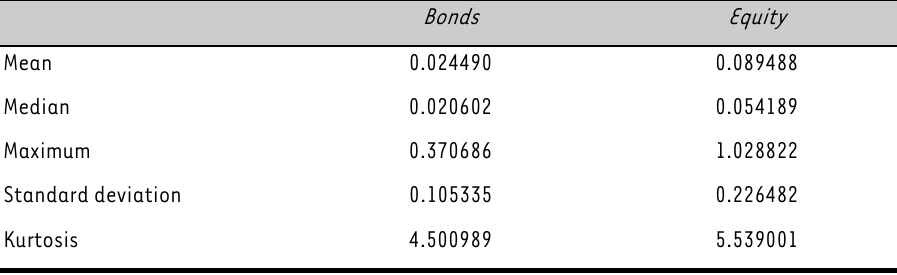
TABLE 3: Descriptive statistics: real equity and bond returns, 1900-2005